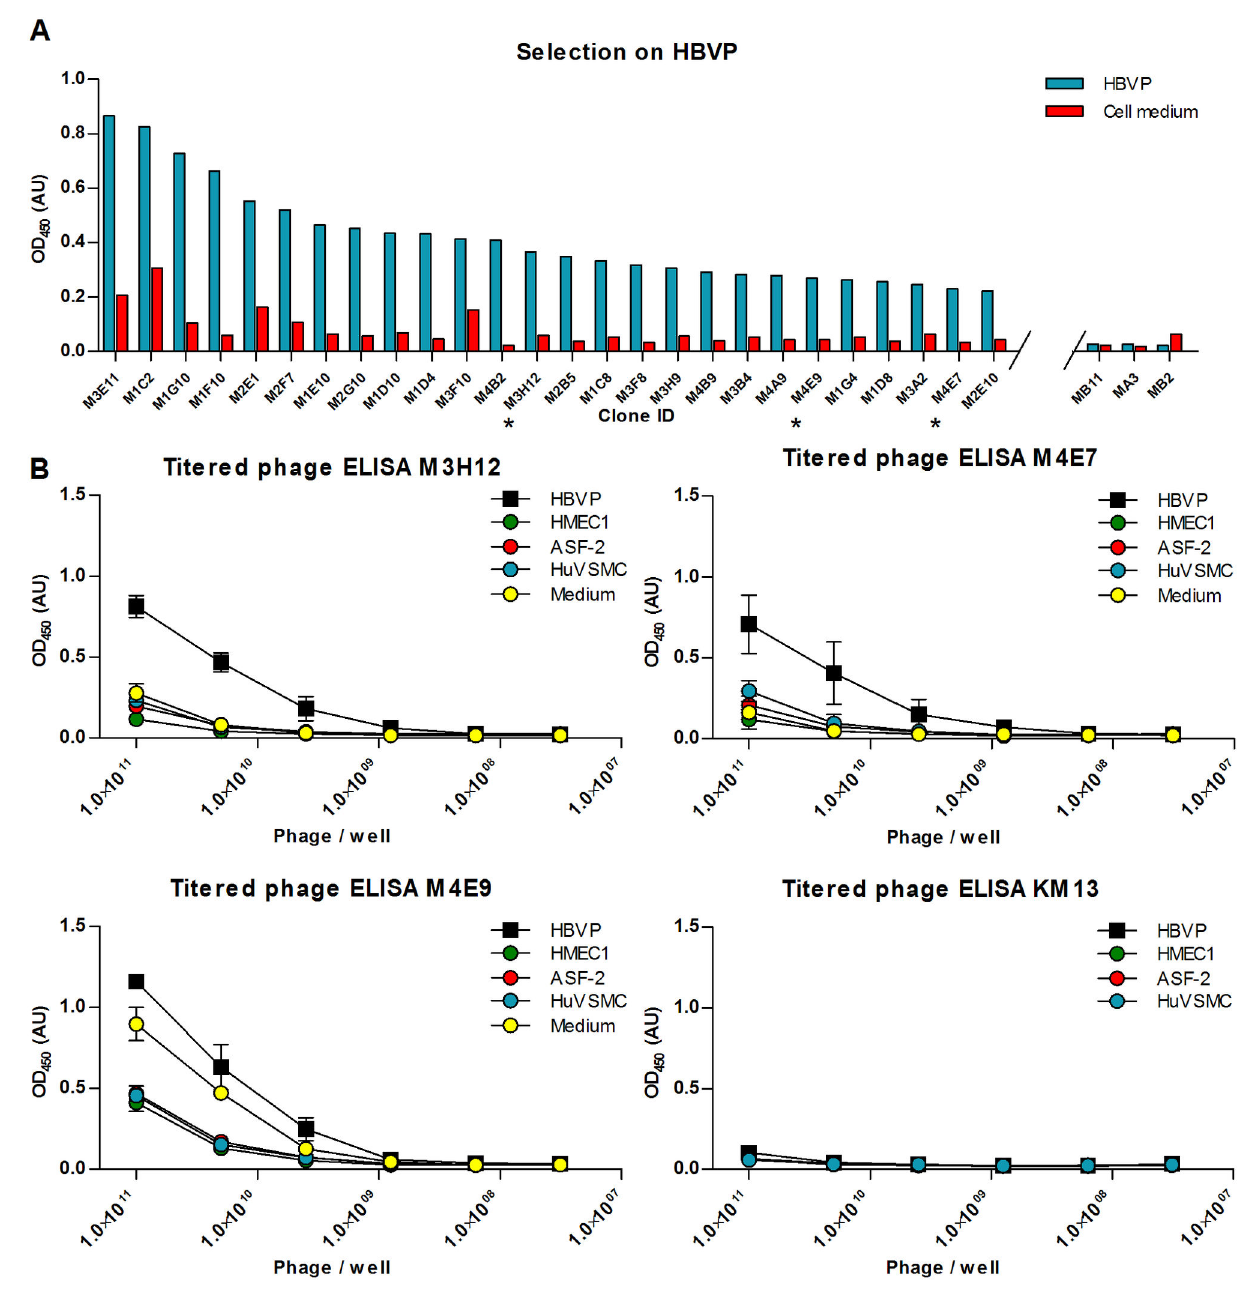
Figure 8. Screening ELISA from selection on HBVP cells and antibody-phage ELISA dilution series on HBVP. ( A ) The clones shown are the ones for which the signal on HBVP-cells was highest, and for which the signal on cell medium did not exceed 25% of the signal on cells. The three clones with the lowest signal among the 384 clones screened are shown for comparison. Blue bars depict the signal on HBVP cells, whereas signal on medium is depicted in red. The result was obtained after one round of selection on immobilized HBVP cells. Clones marked with an asterisk were examined further in titered ELISA. ( B ) Three of the clones from the screening ELISA were tested further in a titered phage ELISA in microwells. The x-axis of the graphs depicts the titer for serial dilutions of the phages displaying the selected domain antibodies, and the y-axis depicts the ELISA signal. The signal on HBVP cells is marked with boxes, while the signal on various decoy cells and on cell medium is marked with circles. The error bars show one standard deviation calculated on the basis of three independent experiments. doi: